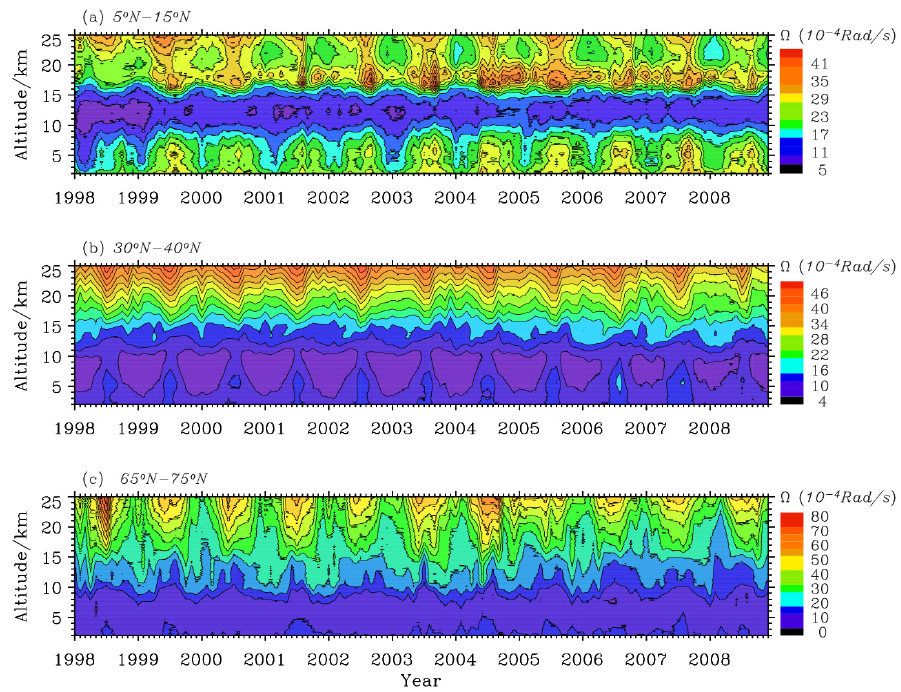
Figure 6. Monthly averaged intrinsic frequencies (in 10 − 4 rads − 1 ) of high-frequency gravity waves at low (a) , middle (b) and high (c)